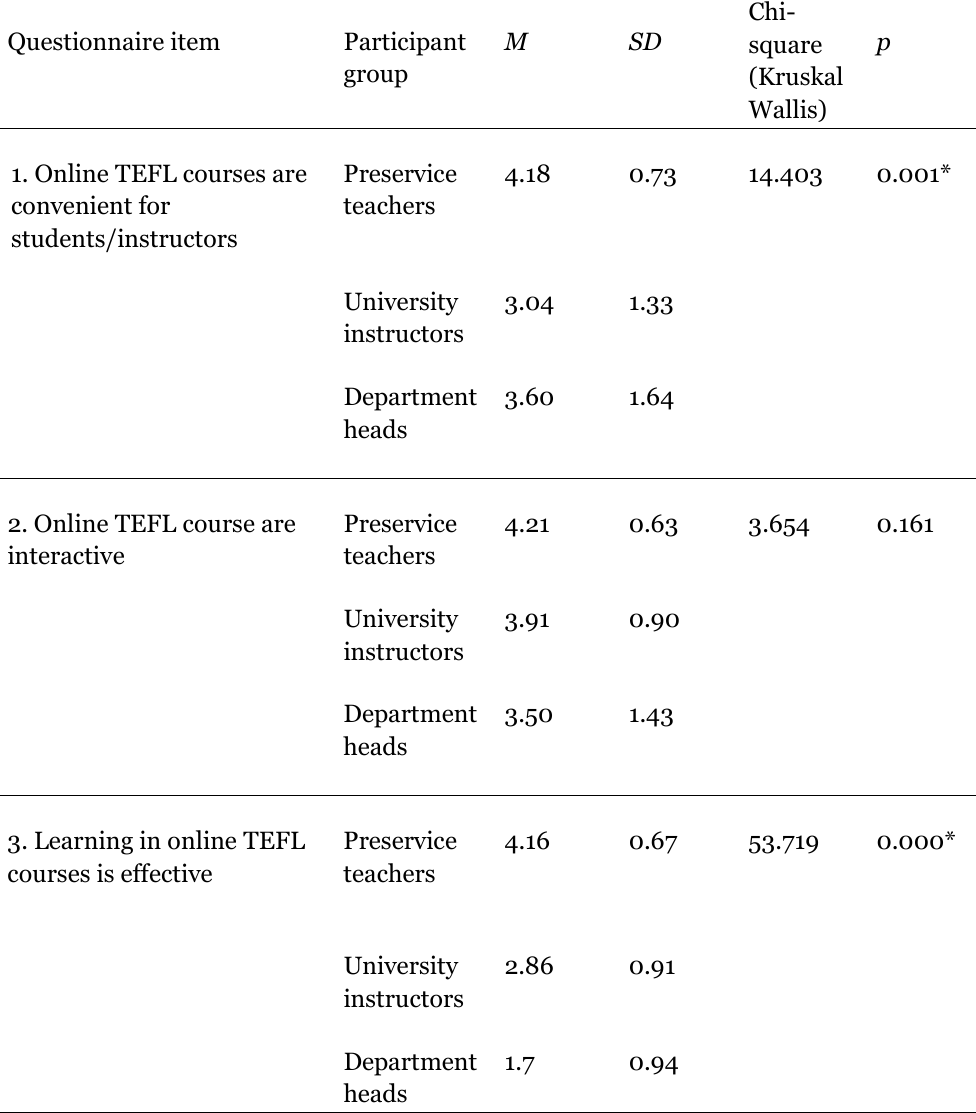
Questionnaire Results on TEFL Stakeholders’ Acceptance of Online TEFL Courses